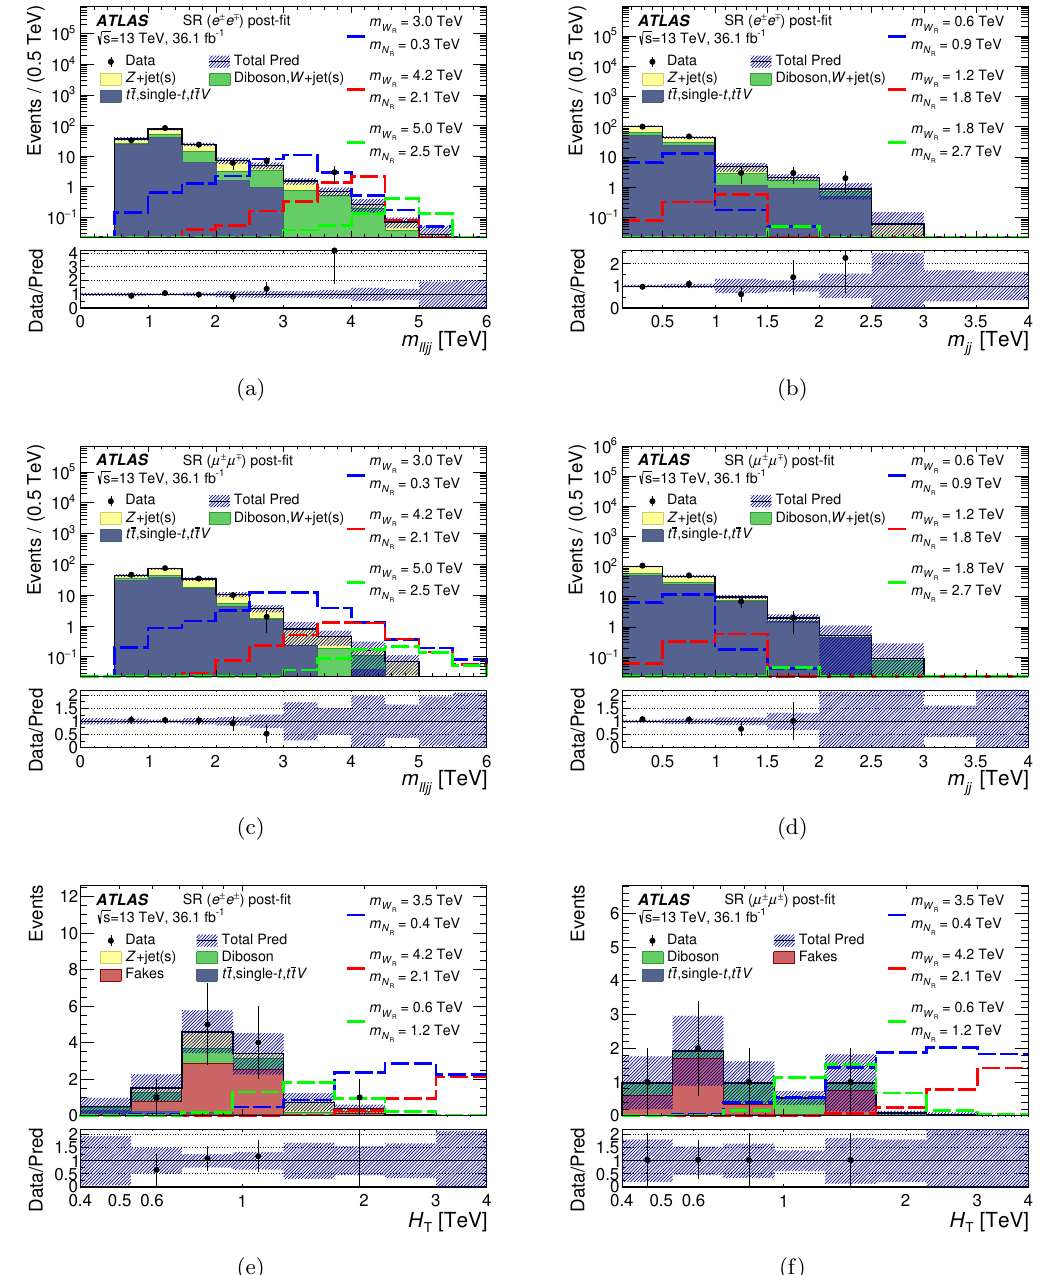
Figure 6 . Distributions for data and background predictions after the CR+SR (cid:12)t for discriminant variables in various signal regions and channels: (a) m ‘‘jj in SR( e (cid:6) e (cid:7) ), (b) m jj in SR( e (cid:6) e (cid:7) ), (c) m ‘‘jj in SR( (cid:22) (cid:6) (cid:22) (cid:7) ), (d) m jj in SR( (cid:22) (cid:6) (cid:22) (cid:7) ), (e) H T in SR( e (cid:6) e (cid:6) ), and (f) H T in SR( (cid:22) (cid:6) (cid:22) (cid:6) ). The hatched bands include all post-(cid:12)t systematic uncertainties. The correlation between sources of systematic uncertainties are taken into account. A few simulated signal distributions, normalised to the predicted cross-section, are overlaid on top of the background prediction in the plots. The last bin in each histogram contains the